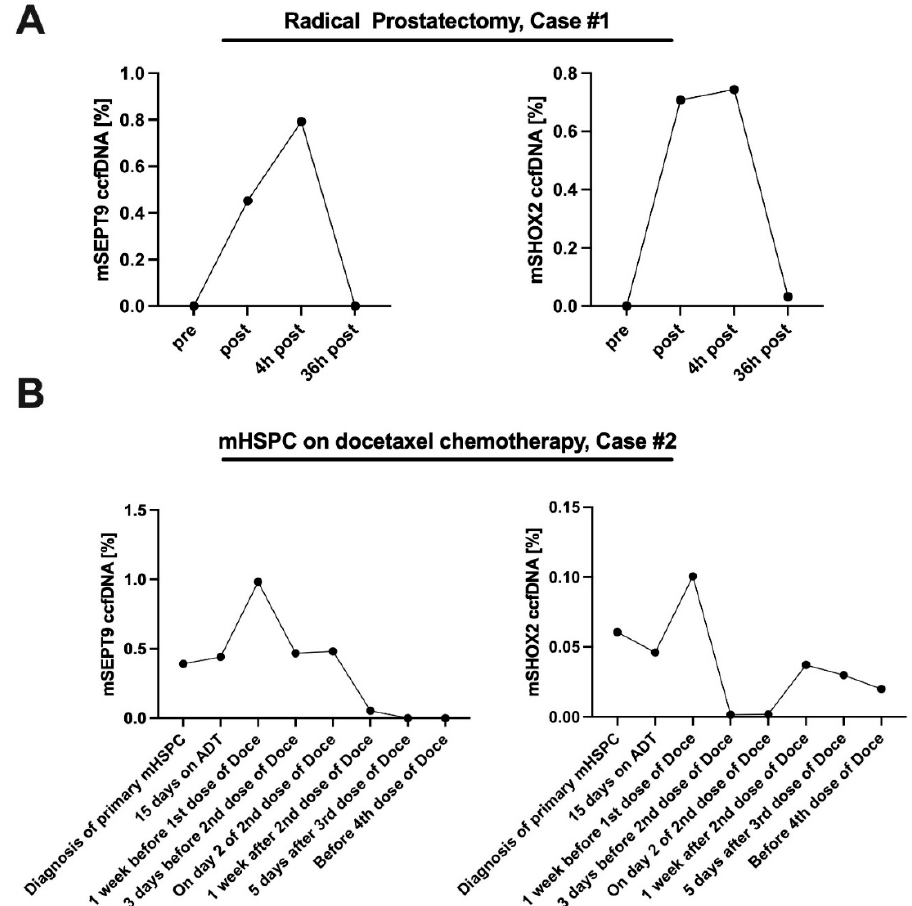
Figure 5. Quantitative methylated SEPT9 and SHOX2 ccfDNA in men undergoing radical prosta- tectomy and chemotherapy for metastatic PCa. The figures show representative courses of the methylation levels of SEPT9 ( Septin 9) and SHOX2 ( short stature homeobox 2 ) of two study patients: ( A ) in the context of radical prostatectomy and ( B ) in the context of chemotherapy with docetaxel for hor- mone sensitive metastatic prostate cancer (mHSPC).